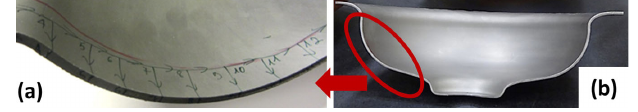
FIG. 9. Images of EHF niobium: (a) example of specimens which were extracted along the profile of the half-cell; (b) section of a half-cell.